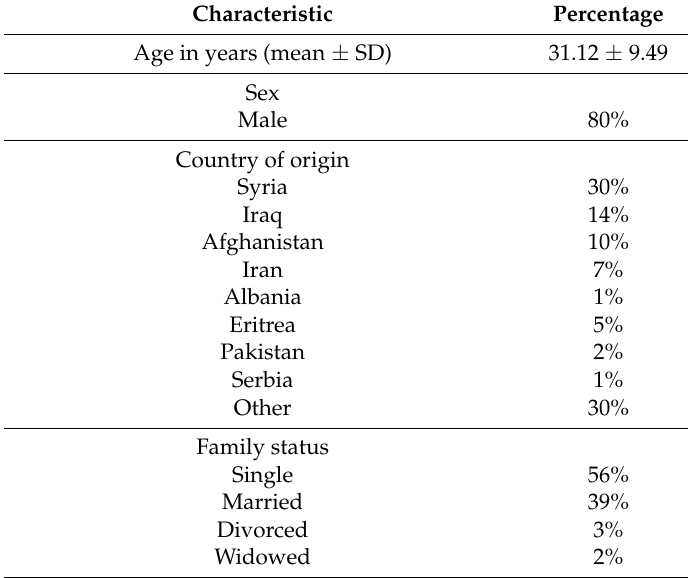
Table 1. Description of the main characteristics of the analyzed sample ( n = 353; rounded